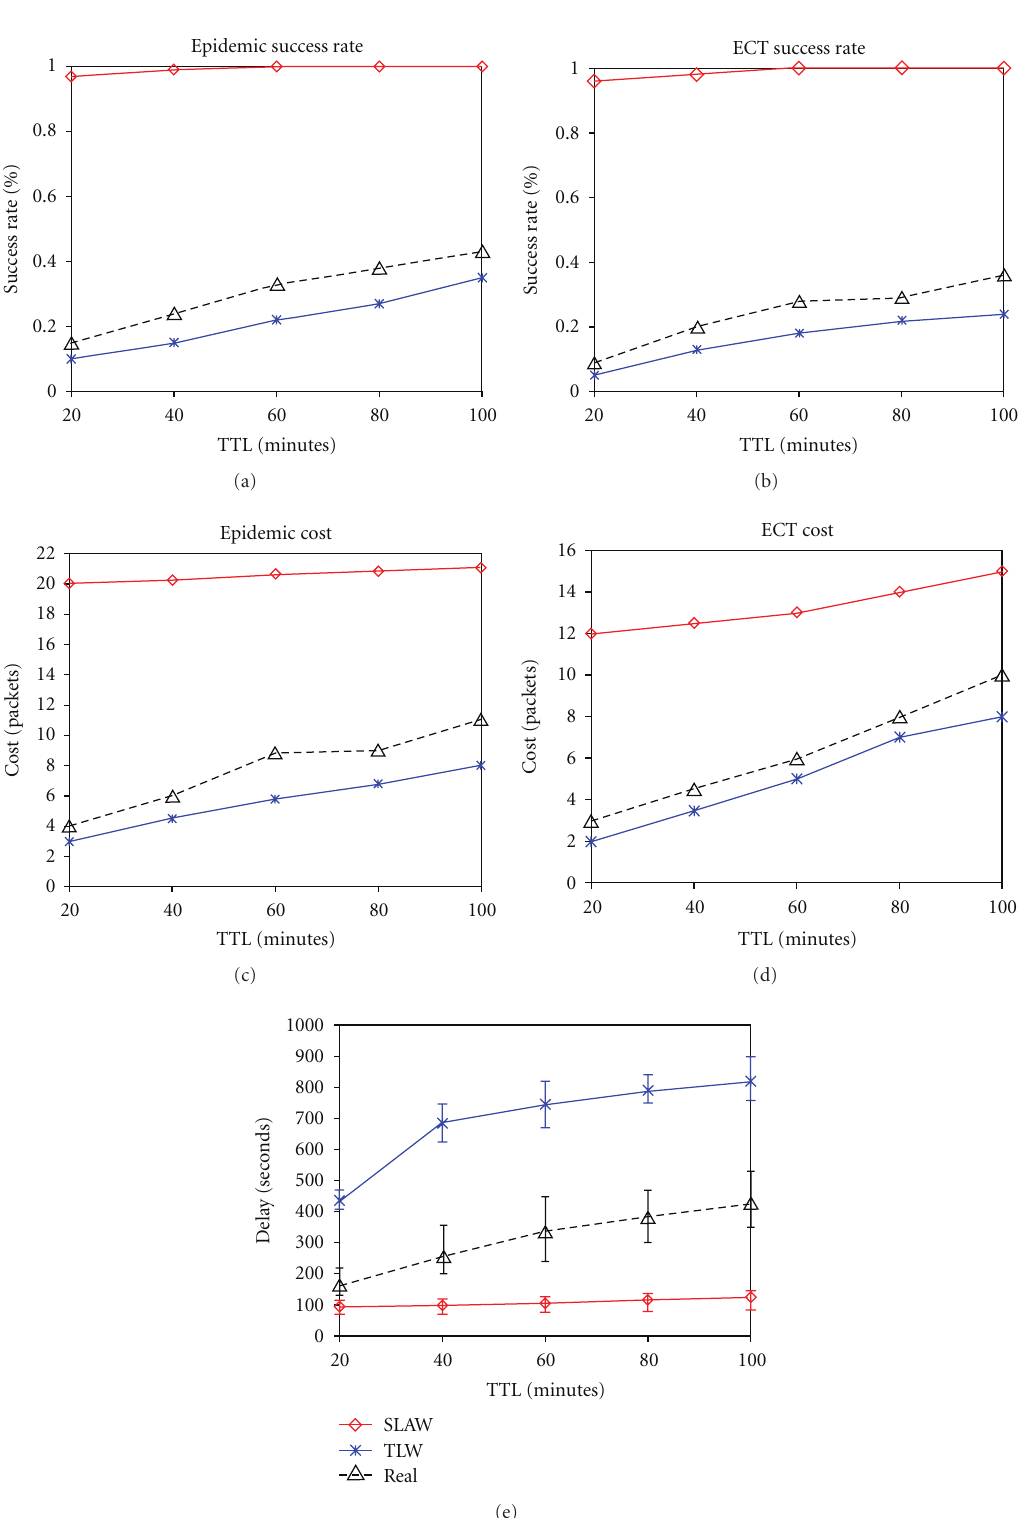
Figure 7: Performance comparison of Epidemic Forwarding and ECT routing protocols for a real trace and two (SLAW and TLW) mobility models. (a) Success rate for Epidemic Forwarding, (b) Success rate for ECT, (c) Cost for Epidemic Forwarding, (d) Cost for ECT, and (e) End to end delay for